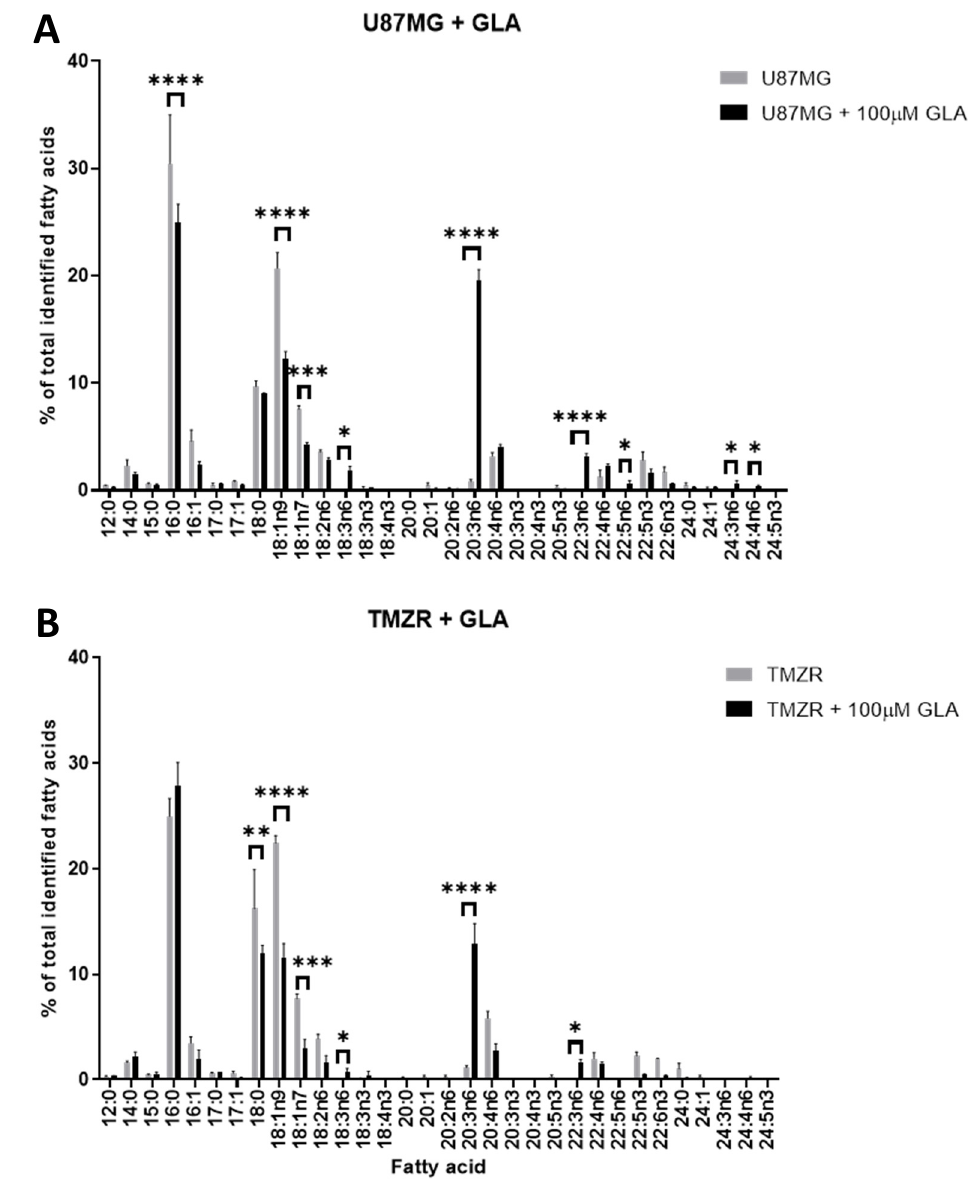
Figure 5. Effects of gamma-linolenic acid (GLA) on fatty acid composition of U87MG and TMZR cells ( A ) U87MG cells ( B ) TMZR cells. Data are presented as mean ± SEM, N = 3. Differences were considered significant at p < 0.05. * = p < 0.05; ** = p < 0.01; *** = p < 0.001; ****= p < 0.0001.